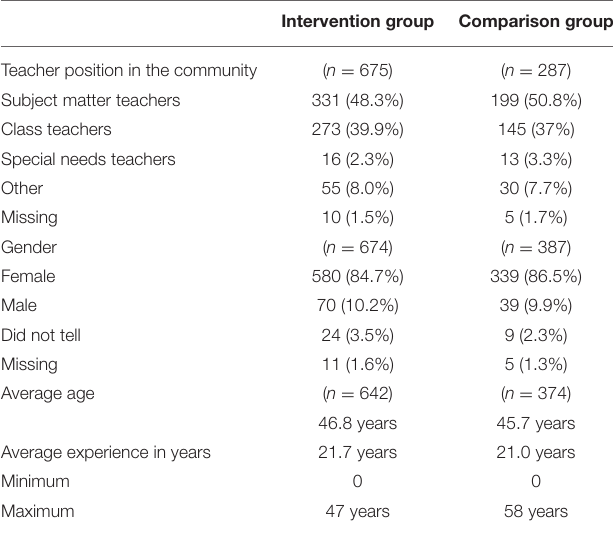
TABLE 2 | Characteristics of the teachers of the intervention and comparison groups. Intervention group Comparison